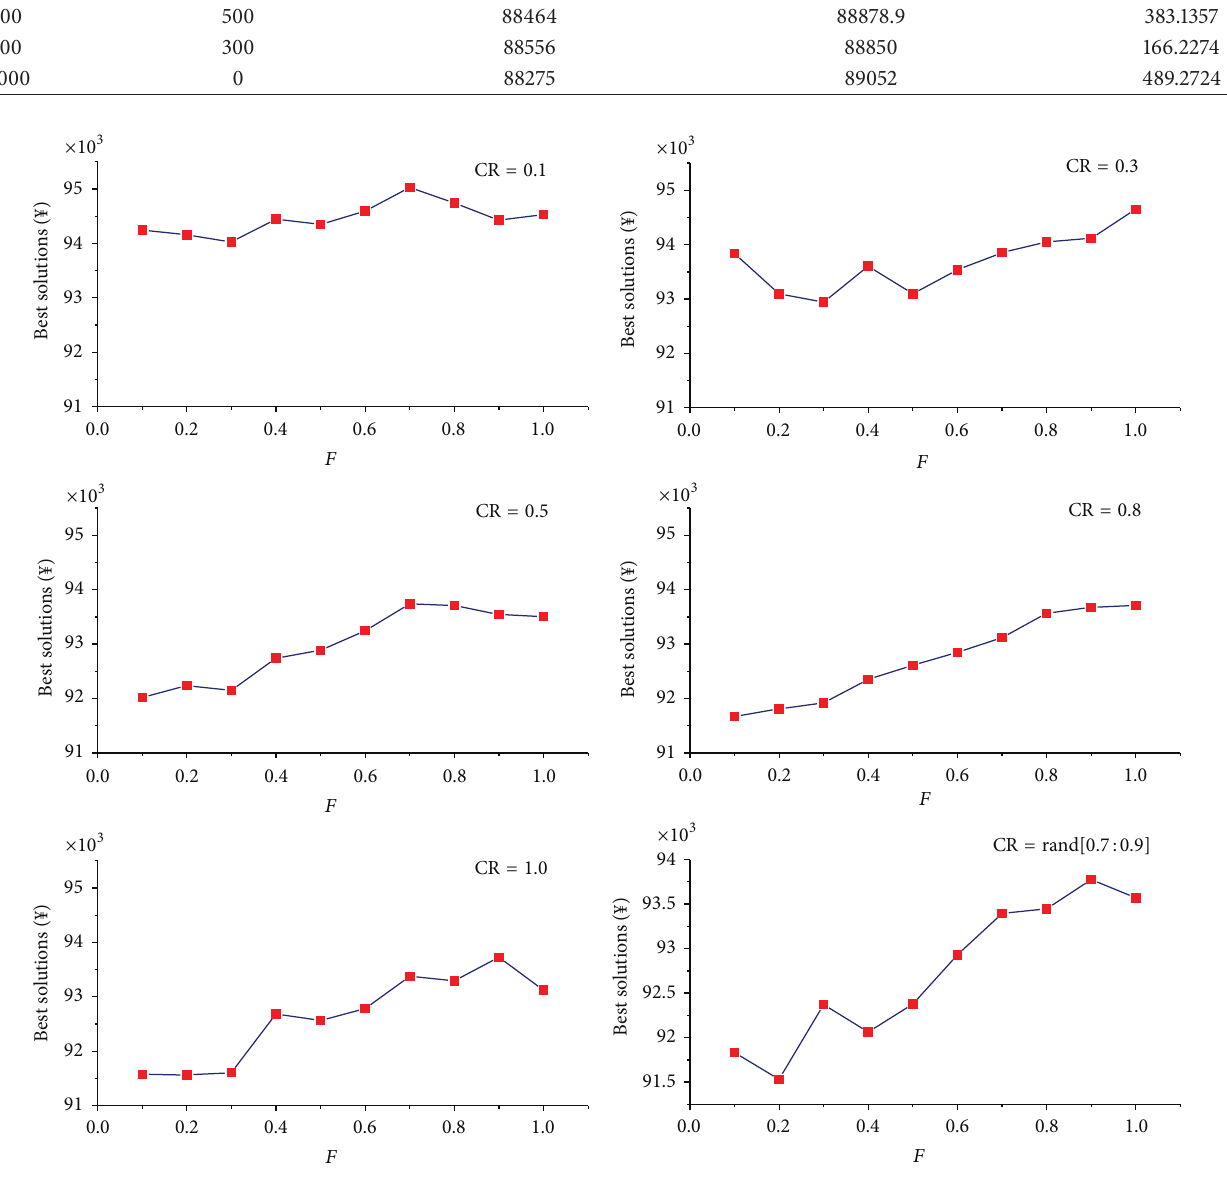
Figure 4: Analysis of 𝐹 in different